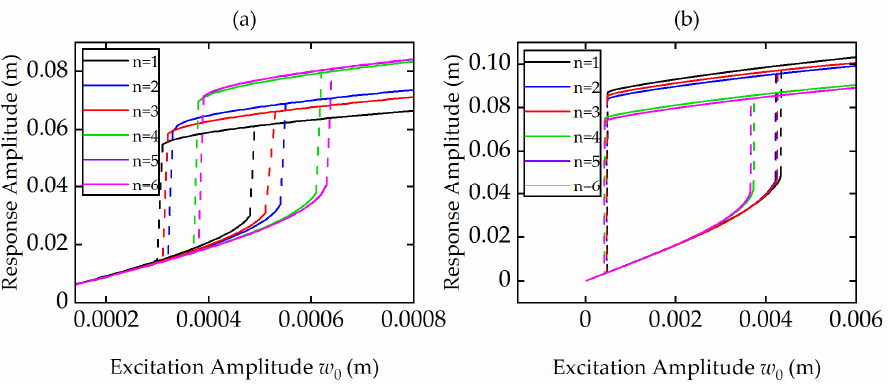
Figure 7. Amplitude response curves of the INDM ( a ) and the CNDM ( b ) with the first n modes.